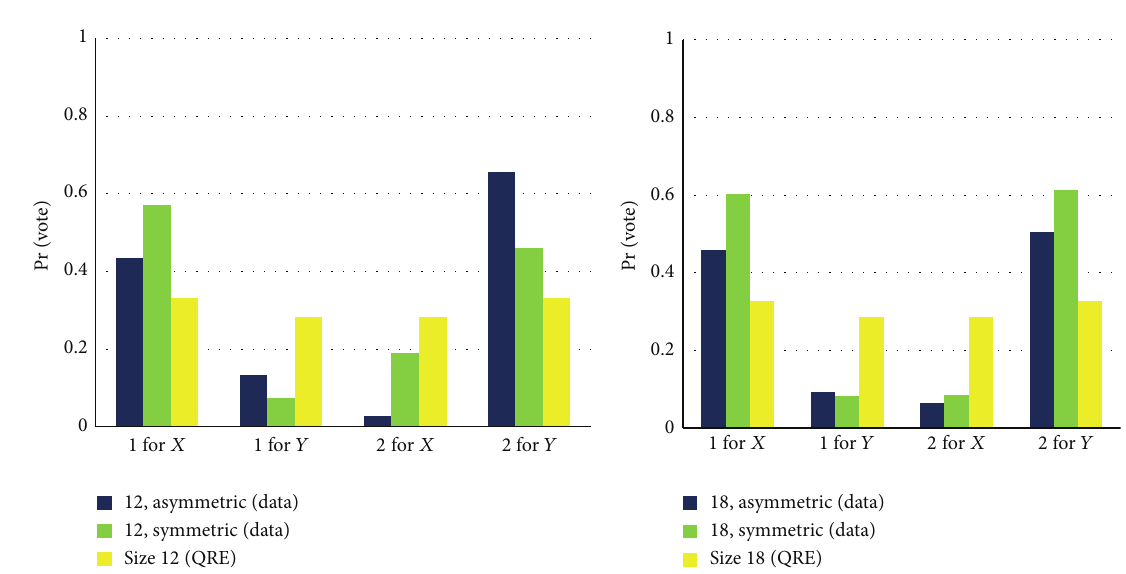
Figure 4: QRE versus data, rounds